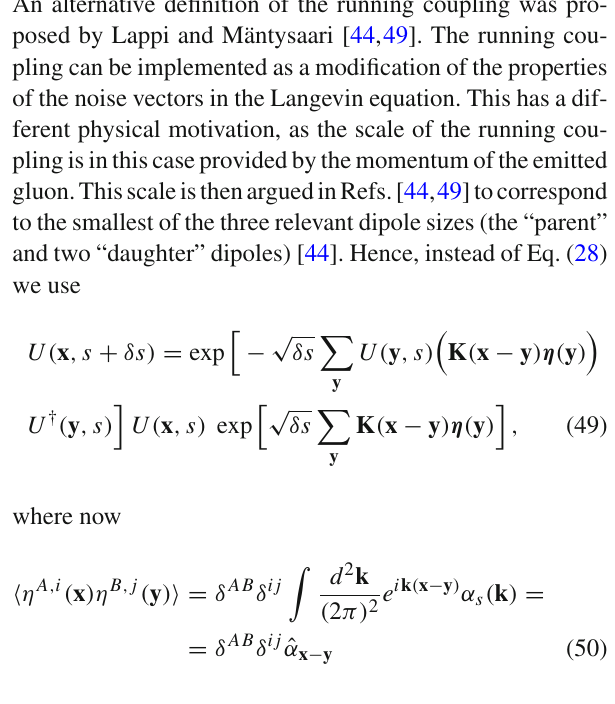
Fig. 3 Comparison of Fourier transformed position space discretized JIMWLK kernels with their momentum definitions as in Eq. (42) on a 16 × 16 lattice. The size of the lattice is chosen such that it allows to show on a single plot all the values of the two kernels and identify the regions where the differences are largest/smallest. Quantitative esti- mation of their impact is presented in subsequent figures using lattices with phenomenologically relevant sizes. The horizontal axis shows n x , whereas different values of n y are shown with different symbols and